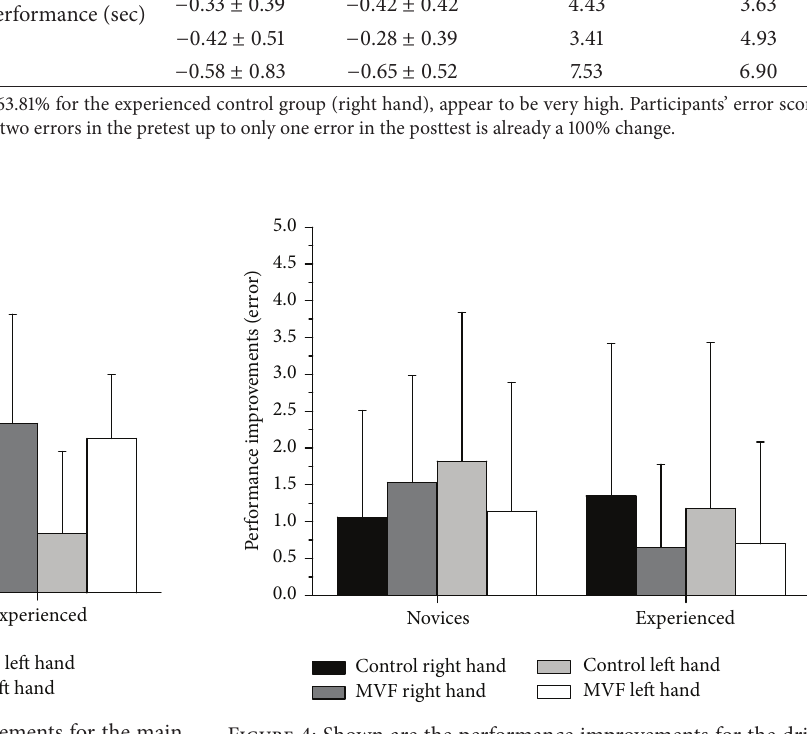
Figure 4: Shown are the performance improvements for the drib- bling error, which was assessed for the dribbling task performed at the mirror box. Error improvements were calculated by subtracting prevaluesfrompostvaluesandaredepictedseparatelyfornoviceand experienced groups. Illustrated scores are absolute means, and error barsindicatestandarddeviations.Notethatapositivevalueindicates improvement; statistics are explained in the